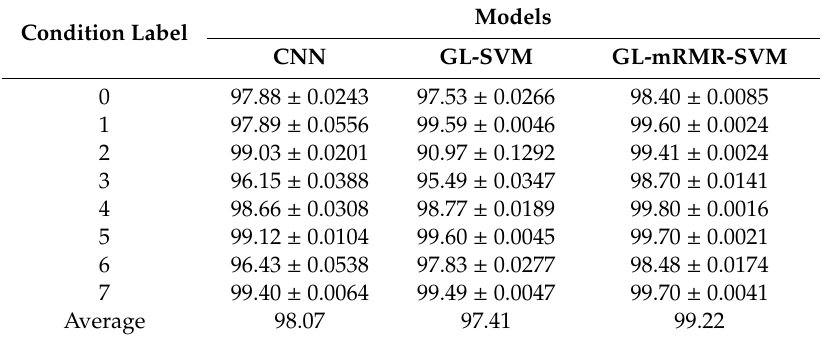
Table 6. Experimental results with different models in term of F1 measure for each condition (%).